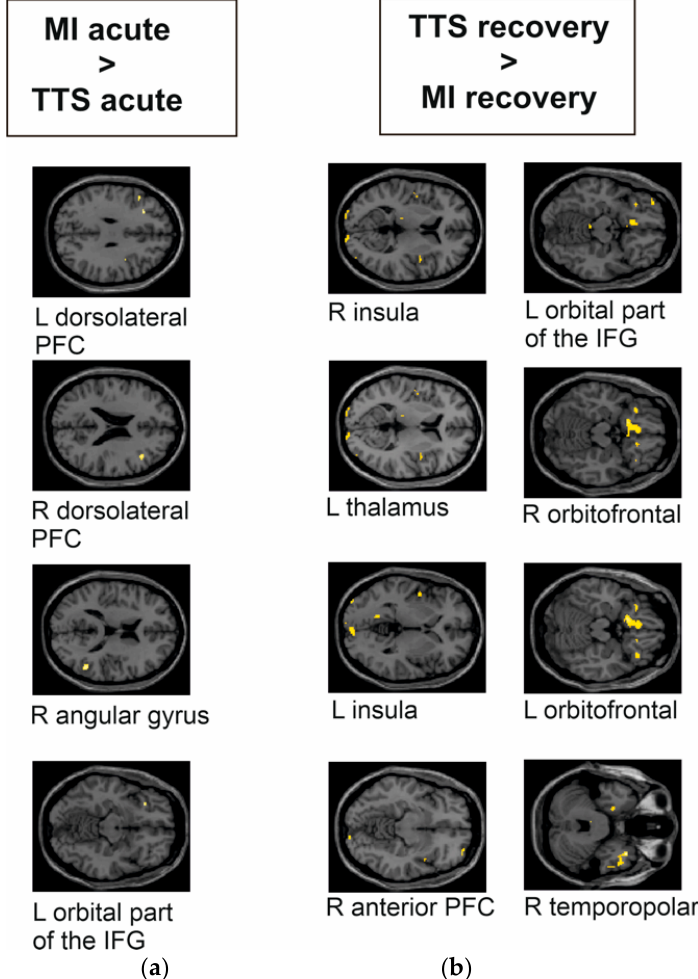
Figure 4. Group differences of TTS and MI during the emotional task-based fMRI paradigm during the decoding of aversive versus positive pictures from the IAPS. The images are presented in MNI space. ( a ) TTS acute phase compared to MI acute phase had significantly lower response in the left and right dorsolateral PFC, right angular gyrus, and left orbital part of the IFG. ( b ) TTS recovery phase compared to MI recovery phase had significantly higher response bilaterally in the ( right ) insula, left thalamus, ( left ) insula, ( right ) anterior PFC, ( left ) orbital part of the IFG, ( right , left ) orbitofrontal area, and ( right ) temporopolar area. Table 4. Significant group differences between TTS and MI while viewing the aversive versus pos- itive pictures during the emotional task-based fMRI paradigm.